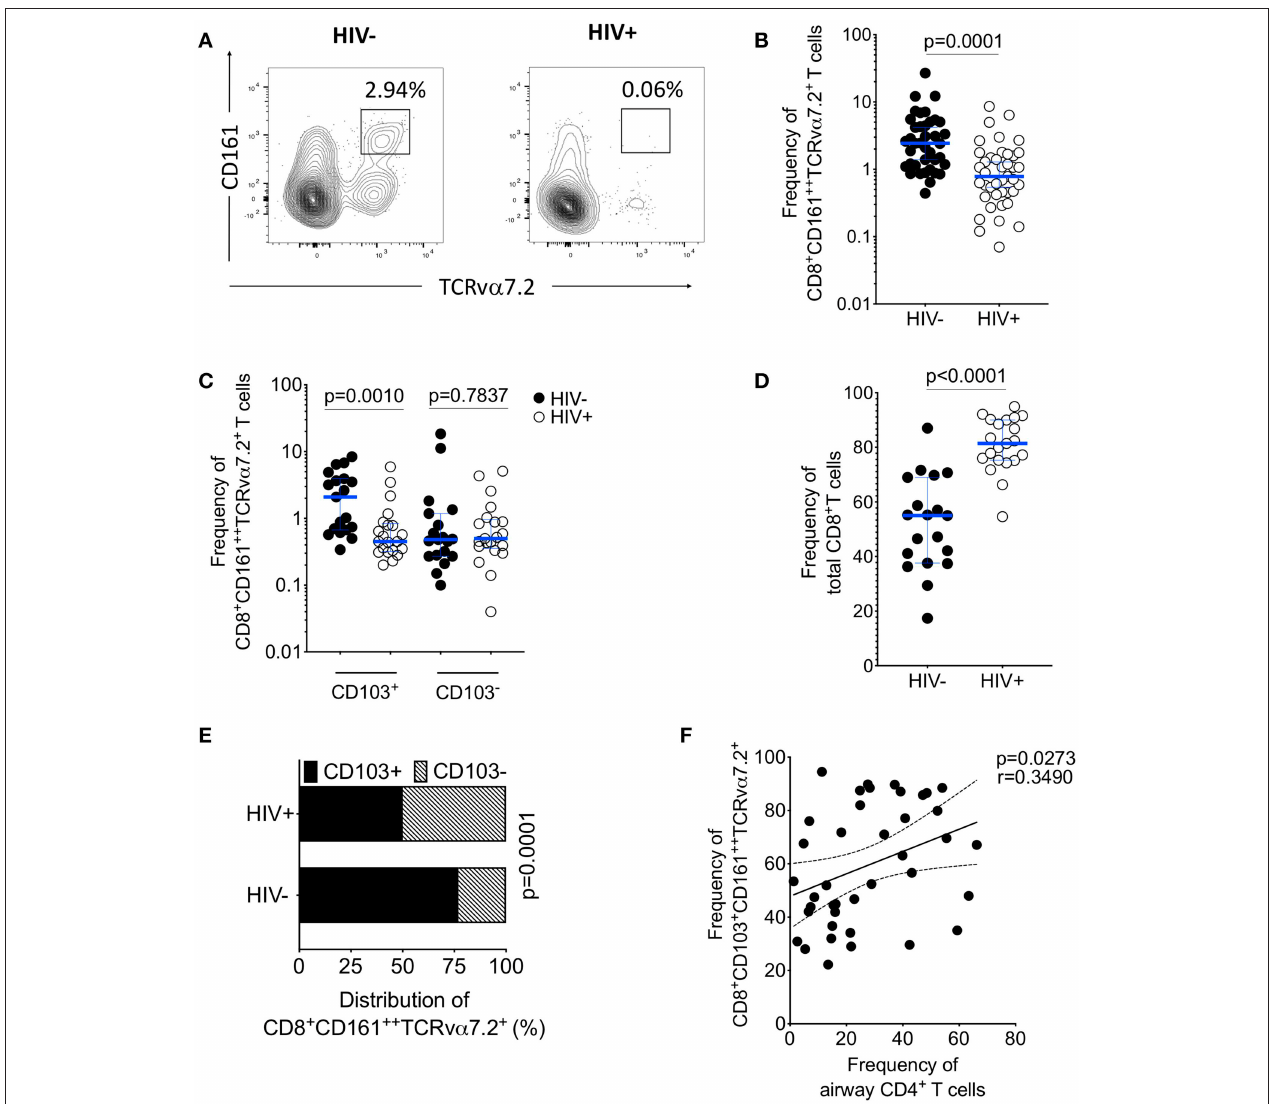
FIGURE 4 | Depletion of airway CD103 + CD8 + CD161 ++ TCRv α 7.2 + T cells in untreated HIV-infected adults. BAL cells from HIV-uninfected and HIV-infected adults were stained with fluorochrome-conjugated antibodies against surface markers of interest. (A) Flow cytometry dot plots showing depletion of CD8 + CD161 ++ TCRv α 7.2 + T cells. (B) Frequency of airway CD8 + CD161 ++ TCRv α 7.2 + T cells in HIV-infected individuals compared to healthy controls (HIV − , n = 39; HIV + , n = 41). (C) Frequency of CD103 + / − airway CD8 + CD161 ++ TCRv α 7.2 + T cells in HIV-infected individuals compared to healthy controls (HIV − , n = 19; HIV + , n = 21). (D) Frequency of total CD8 + T cells and CD4 + T cells in HIV-infected individuals compared to healthy controls (HIV − , n = 19; HIV + , n = 21). (E) Distribution of CD103 + / − airway CD161 ++ TCRv α 7.2 + T cells in HIV-infected individuals compared to healthy controls (HIV − , n = 19; HIV + , n = 21). (F)